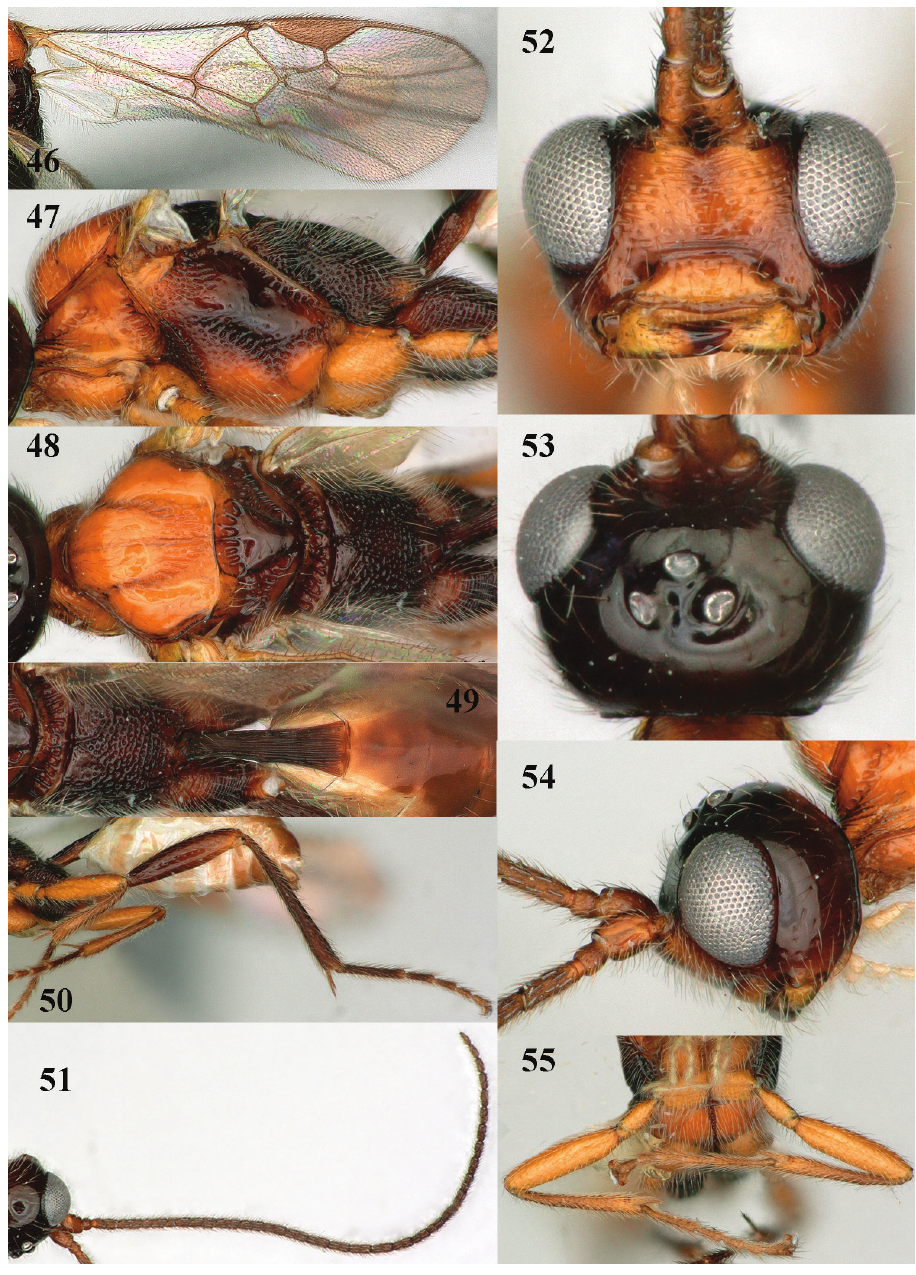
Figures 46–55. Mannokeraia punctata sp. n., ♂ , holotype. 46 wings 47 mesosoma, lateral aspect 48 mesosoma, dorsal aspect 49 propodeum, first–third metasomal tergites, dorsal aspect 50 hind leg, lateral aspect 51 antenna, lateral aspect 52 head, anterior aspect 53 head, dorsal aspect 54 head, lateral aspect 55 fore legs, inner